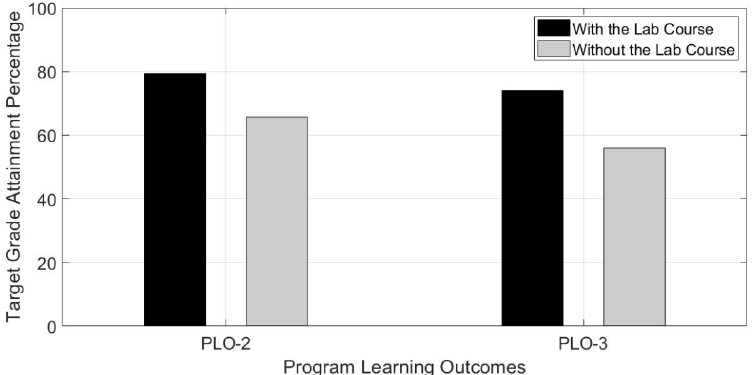
Figure 9. Percentage PLO attainment based on students’ grades for the lecture-based